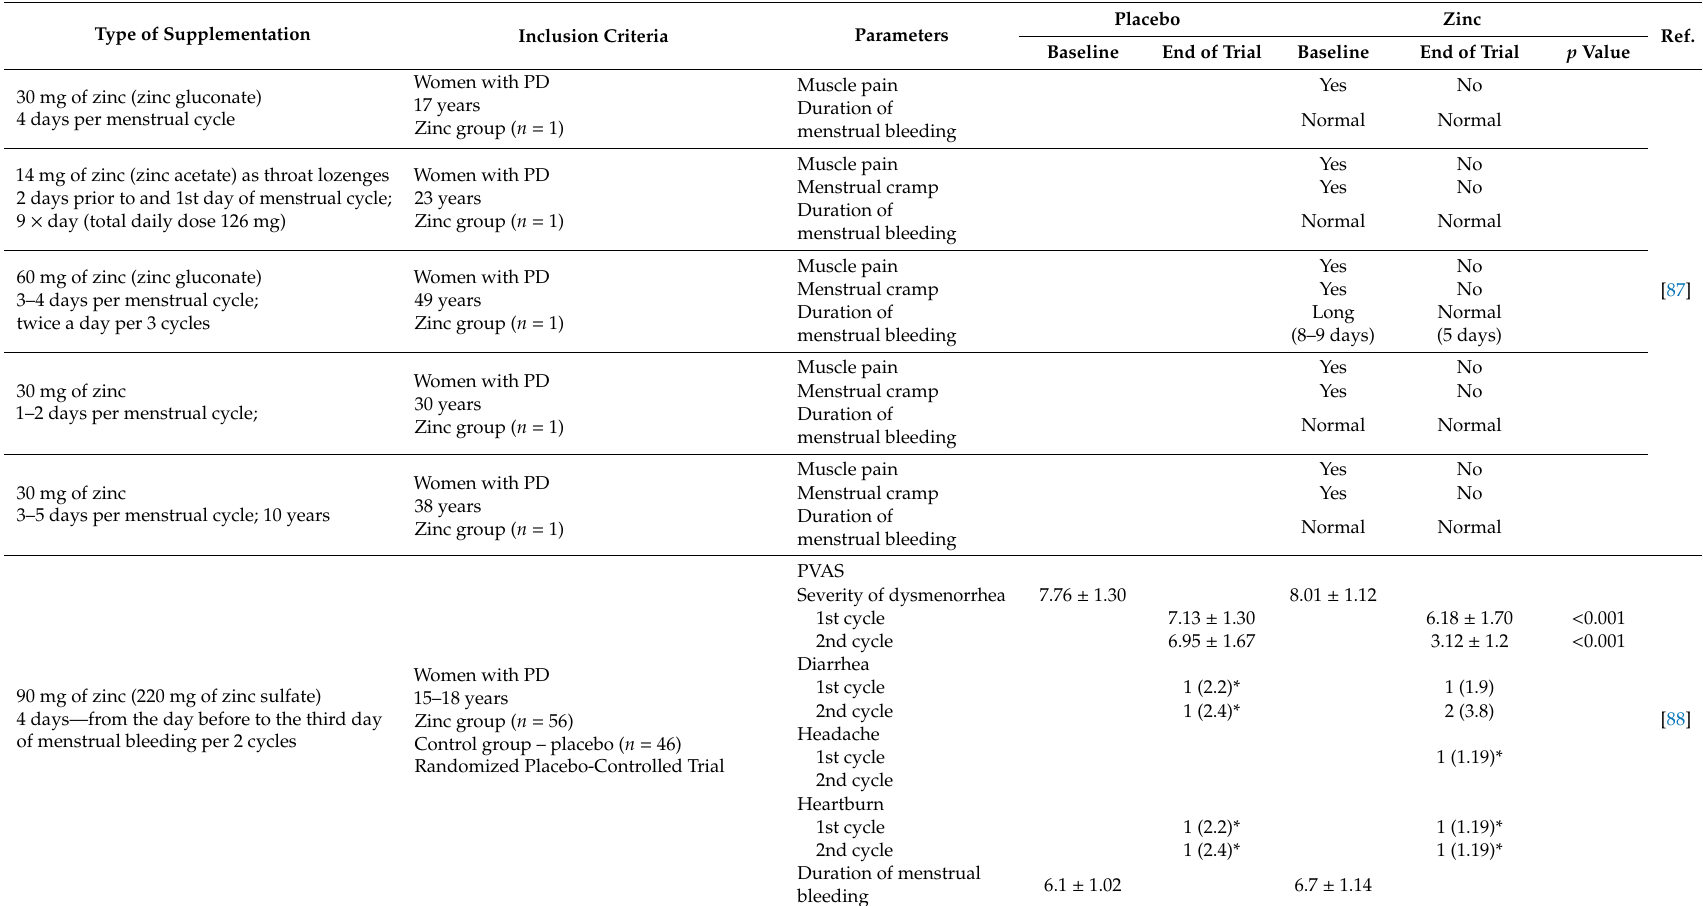
Table 4. The e ff ects of zinc supplementation on various clinical signs in women with primary dysmenorrhea